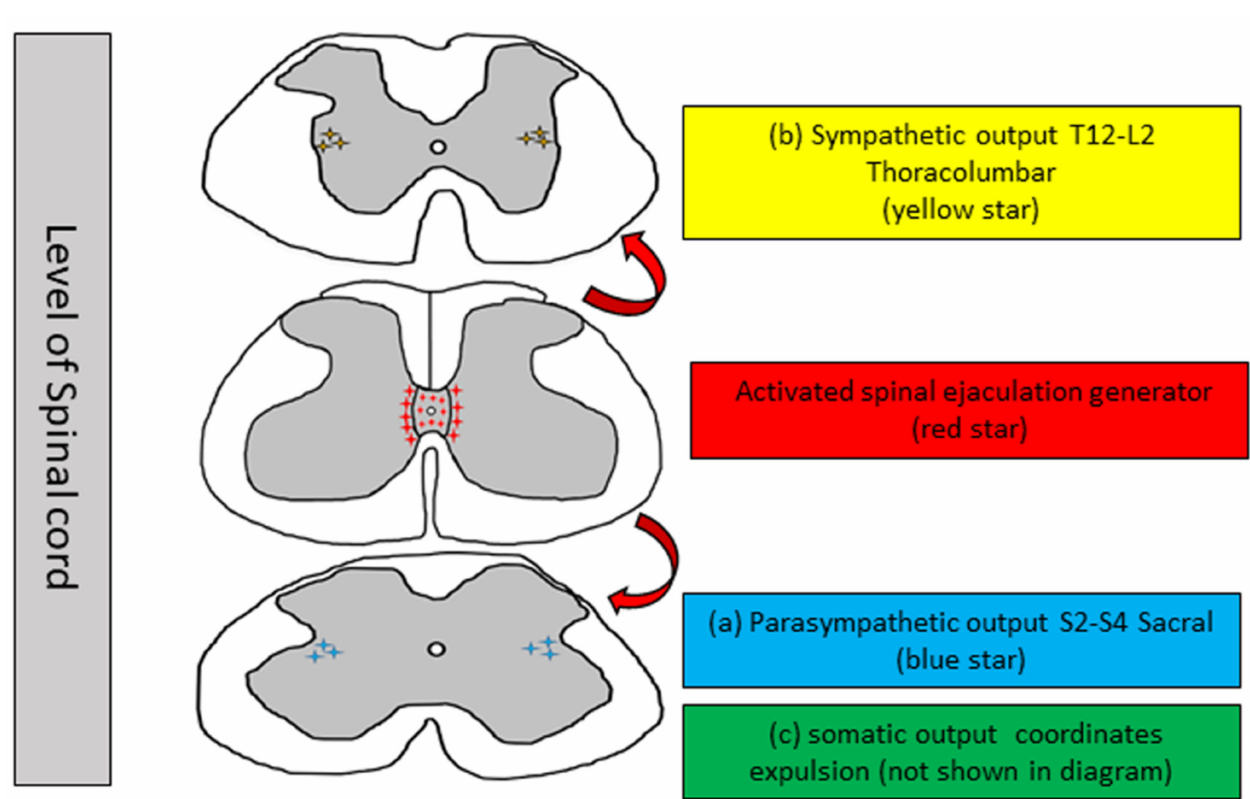
Figure 1. Schematic diagram of level of spinal cord and neurons regulating ejaculation. Activated spinal ejaculation generator directs and synchronizes the activity of: ( a ) parasympathetic output that innervate prostate and seminal vesicles secreting seminal fluid. ( b ) Sympathetic output that innervate smooth muscle cells of the seminal tract and the bladder neck. Contraction of the seminal tract accumulate spermatozoa that is mixed with the seminal fluid to the prostatic urethra. The neck of bladder remains closed to prevent retrograde ejaculation. ( c ) Somatic output that innervate the pelvic striated muscles (not shown in this figure). The external urethral sphincter relaxes and rhythmic contractions of the bulbospongiosus and ischiocavernosus muscles are responsible for rhythmic forceful expulsion of sperm at the urethral meatus. ( a ) and ( b ) = emission; ( c ) =